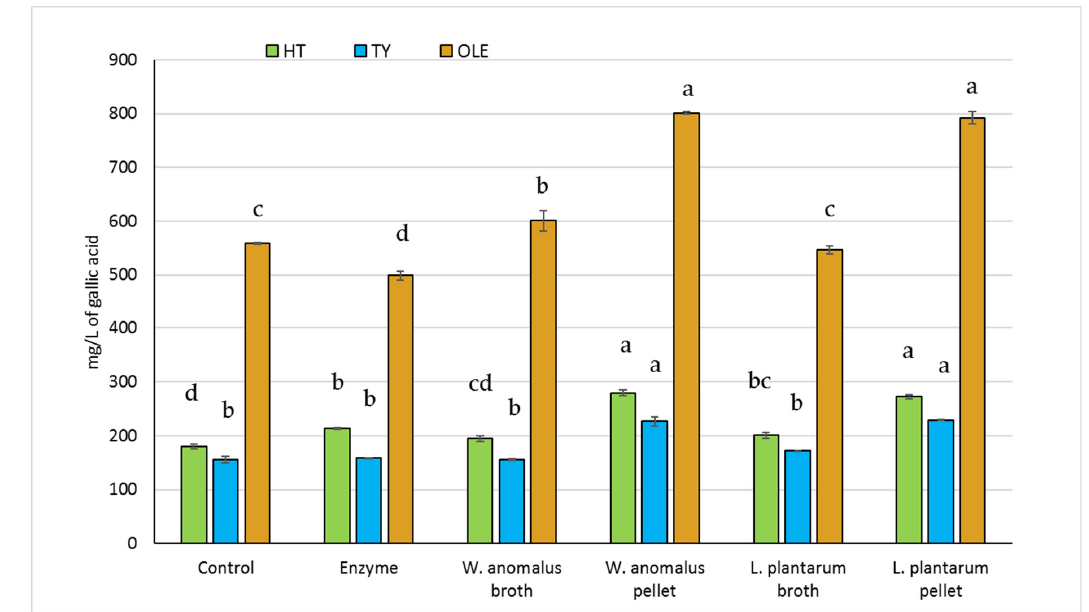
Figure 2. Concentration of hydroxytyrosol, tyrosol, and oleuropein after bioconversion of diluted OMW extract by Lallzyme, extracellular broths and pellets of the two tested strains after 2 h at 50 °C. Different letters indicate statistical differences among the columns of the same compound (Significance at p < 0.001).